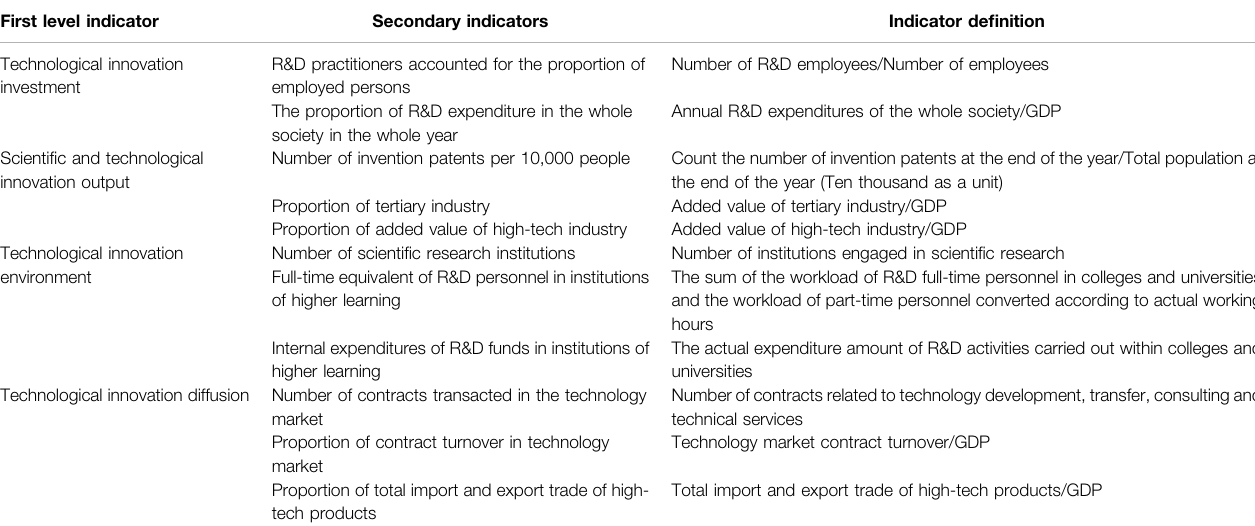
TABLE 3 | Scienti fi c and technological innovation index